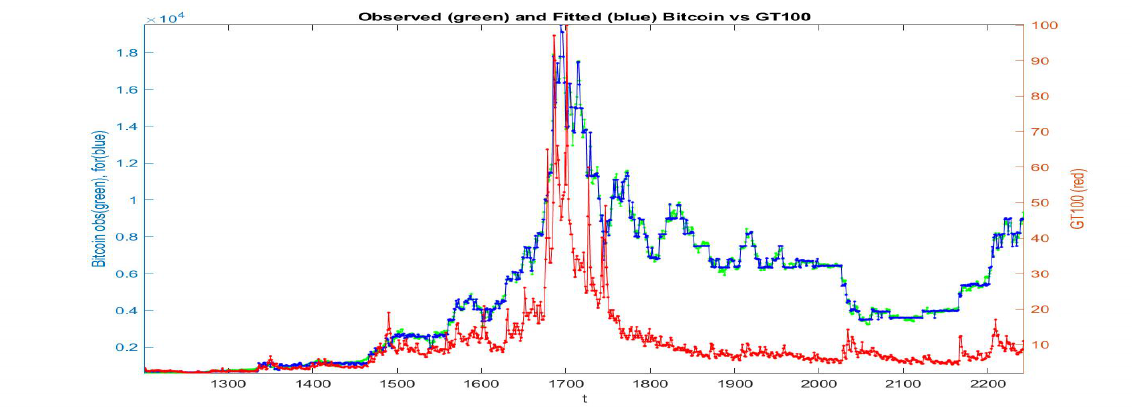
Figure 8. Clustering A: the fitted BitCoin time series (blue colour) is obtained from L 2 -norm iF-transform function applied to the data-set ( GT 100 t , BitCoin t ) ; the observed BitCoin t values are green and the observed GT 100 t values are red.